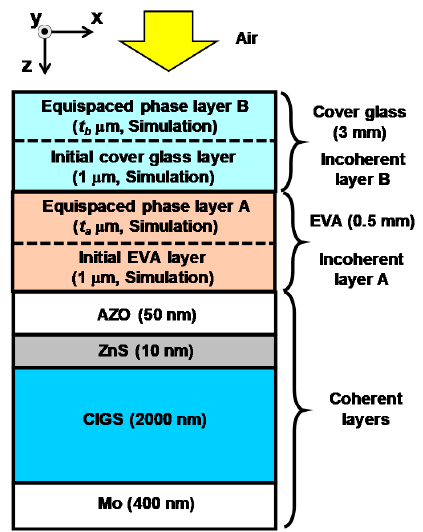
Figure 10. Modified schematic diagram of CIGS solar cell, where a 0.5-mm EVA encapsulation layer was added into the multilayer structure of the CIGS solar cell in Figure 1. Because the thickness of the EVA layer (0.5 mm) was larger than the coherence length of sunlight (~0.6 µ m), the EVA layer should also be considered optically incoherent. Because both a cover glass and EVA have no absorption, two incoherent layers can be modeled as a 1- µ m initial layer plus the EPL, whose respective thicknesses of t a and t b can be determined based on Equation (17) to include the e ff ect of the incoherent cover glass / EVA layers on the optical characteristics based on the